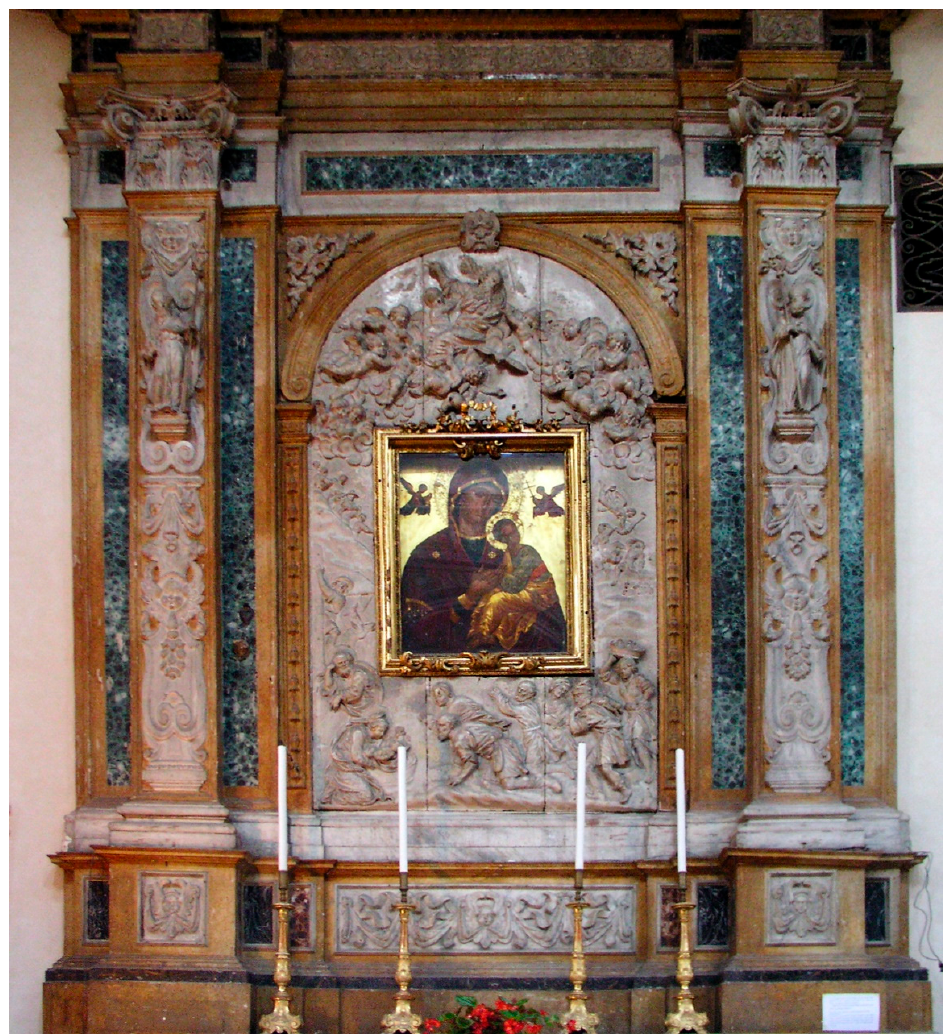
Figure 18. The Madonna of Passion , Ferrara, Church of Santa Maria in Vado (photograph by the author).